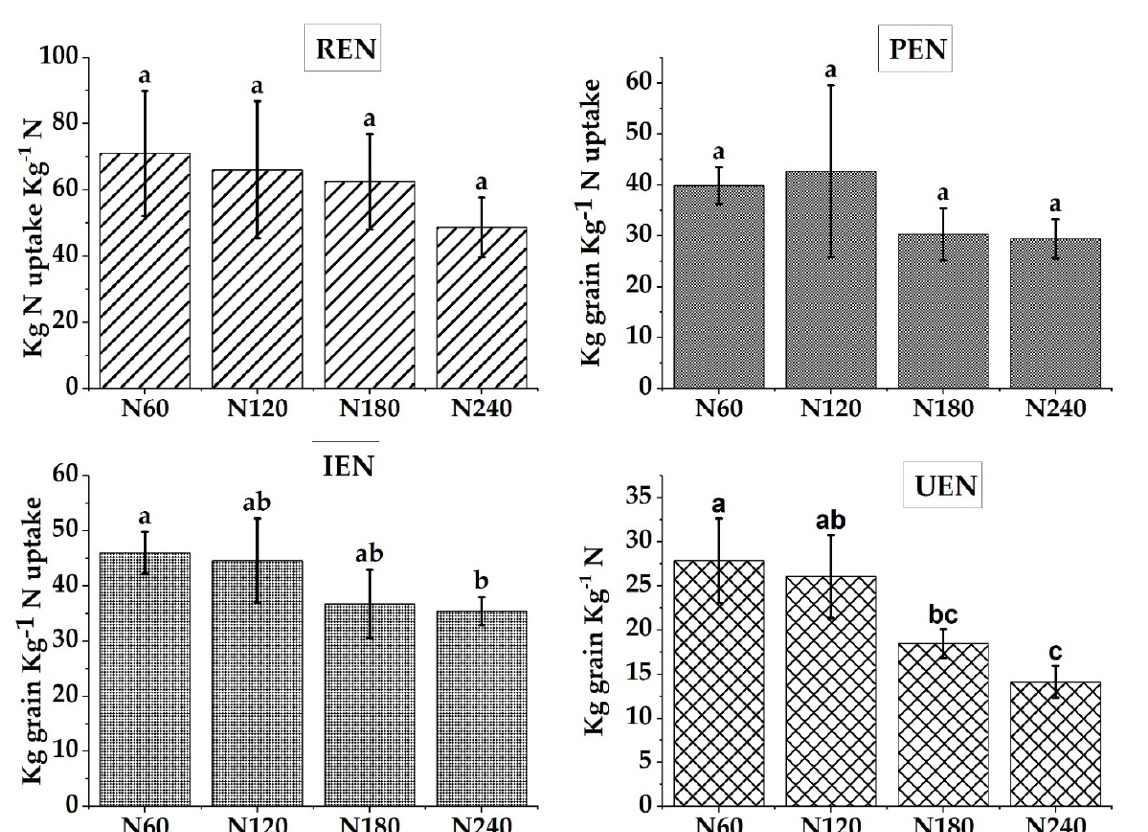
Figure 7. Different components of NUEs as influenced by different N doses. REN; Recovery efficiency of N (kg N uptake kg −1 N), PEN; Physiological efficiency of N (kg grain kg −1 N uptake), IEN; Internal efficiency of N (kg grain kg −1 N uptake), UEN; Utilization efficiency of N (kg grain kg −1 N), N60; 60 kg ha −1 N, N120; 120 kg ha −1 N, N180; 180 kg ha −1 N, N240; 240 kg ha −1 N. Similar letters across the treatments indicate a non-significant effect ( p ≤ 0.05).